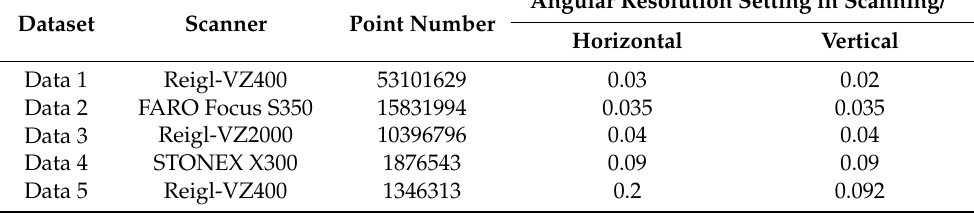
Figure 8. Test data for estimation of angular resolution colored by height. Table 2. Information of test